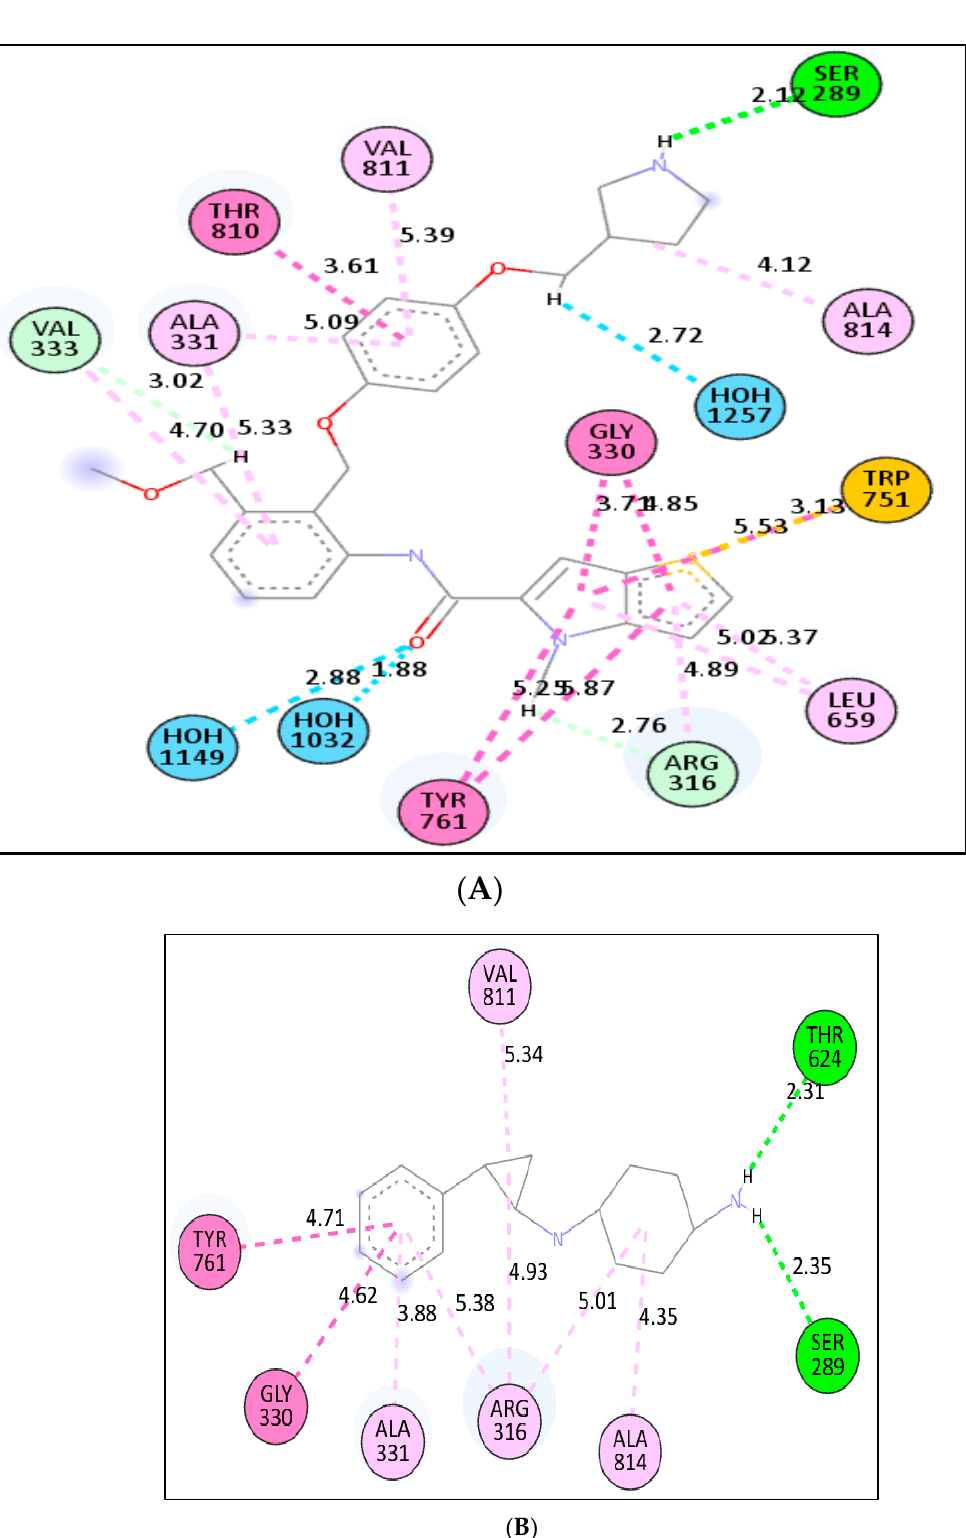
Figure 11. Presentation of the 2D and 3D interactions of compound 4 ( A ) and compound 1 ( B ) with LSD1 receptor.